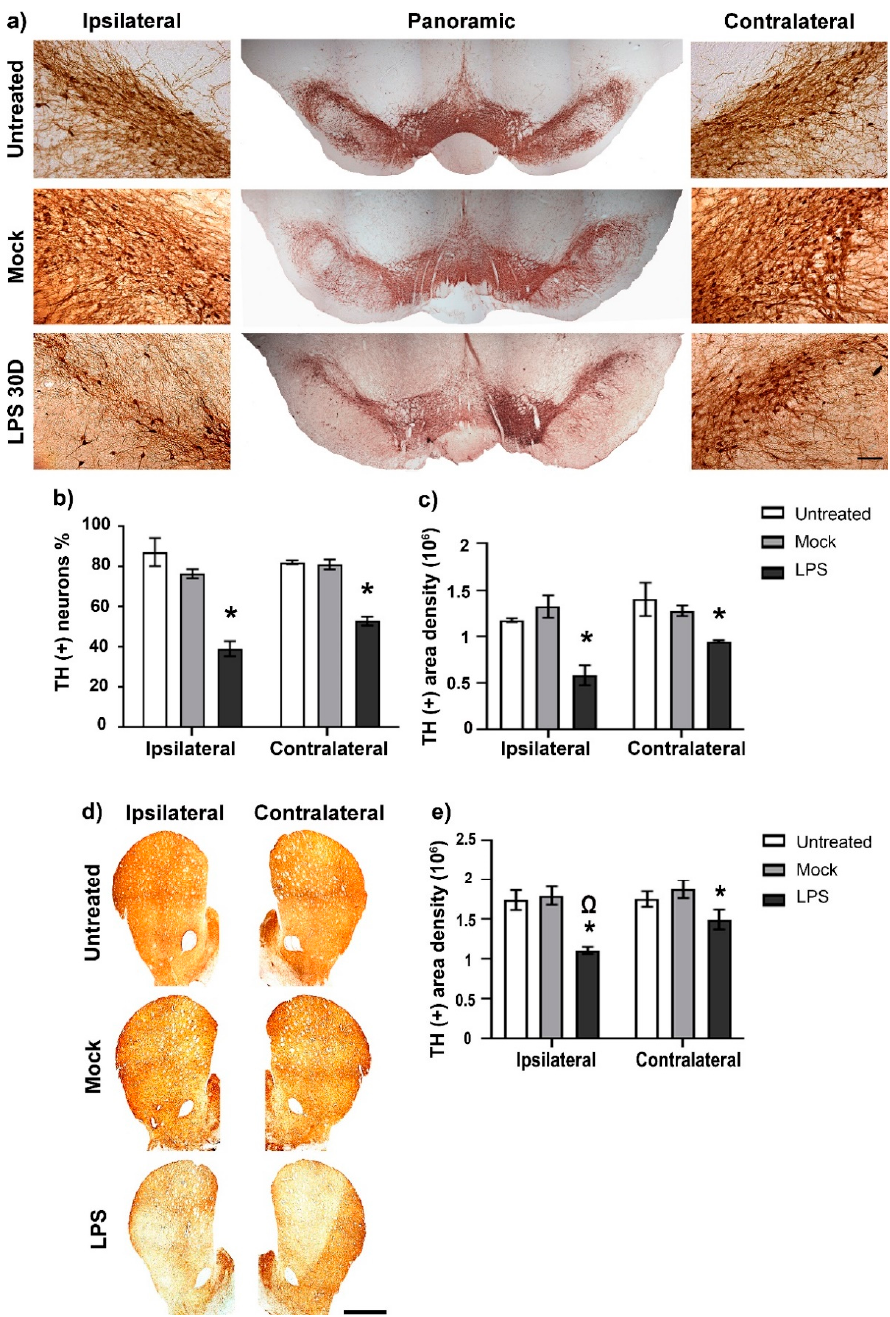
Figure 8 . LPS intranigral injection decreases TH (+) cells and their ramification bilaterally in the Figure 8. LPS intranigral injection decreases TH (+) cells and their ramification bilaterally in the SNpc and the striatum. ( a ) Representative micrographs of the mesencephalon processed with TH SNpc and the striatum. ( a ) Representative micrographs of the mesencephalon processed with TH immunohistochemistry. Lateral panels show 20× amplification of the respective SNpc. ( b ) Neuron immunohistochemistry. Lateral panels show 20 × amplification of the respective SNpc. ( b ) Neuron counting and ( c ) area density measurements in the substantia nigra. ( d ) Representative micrographs of the striatum processed with TH immunohistochemistry and ( e ) their area density measurements. counting and ( c ) area density measurements in the substantia nigra. ( d ) Representative micrographs ImageJ software v.1.46r (National Institutes of Health, Bethesda, MD) was used for quantifying neu- of the striatum processed with TH immunohistochemistry and ( e ) their area density measurements. rons and area density of ramifications. The scale bar = 50 µm for micrographs of ( a ) and 1mm for ImageJ software v.1.46r (National Institutes of Health, Bethesda, MD) was used for quantifying micrographs of ( d ). The values are the mean ± SEM from three anatomical levels ( n = 3 independent neurons and area density of ramifications. The scale bar = 50 µ m for micrographs of ( a ) and 1mm for rats per experimental condition). The asterisk (*) compares LPS groups with the respective Mock micrographs of ( d ). The values are the mean ± SEM from three anatomical levels ( n = 3 independent rats per experimental condition). The asterisk (*) compares LPS groups with the respective Mock group of both SN sides. The symbol ( Ω ) compares the LPS effect on the ipsilateral with that on the contralateral side. One-way ANOVA and post hoc Tukey tests, p <